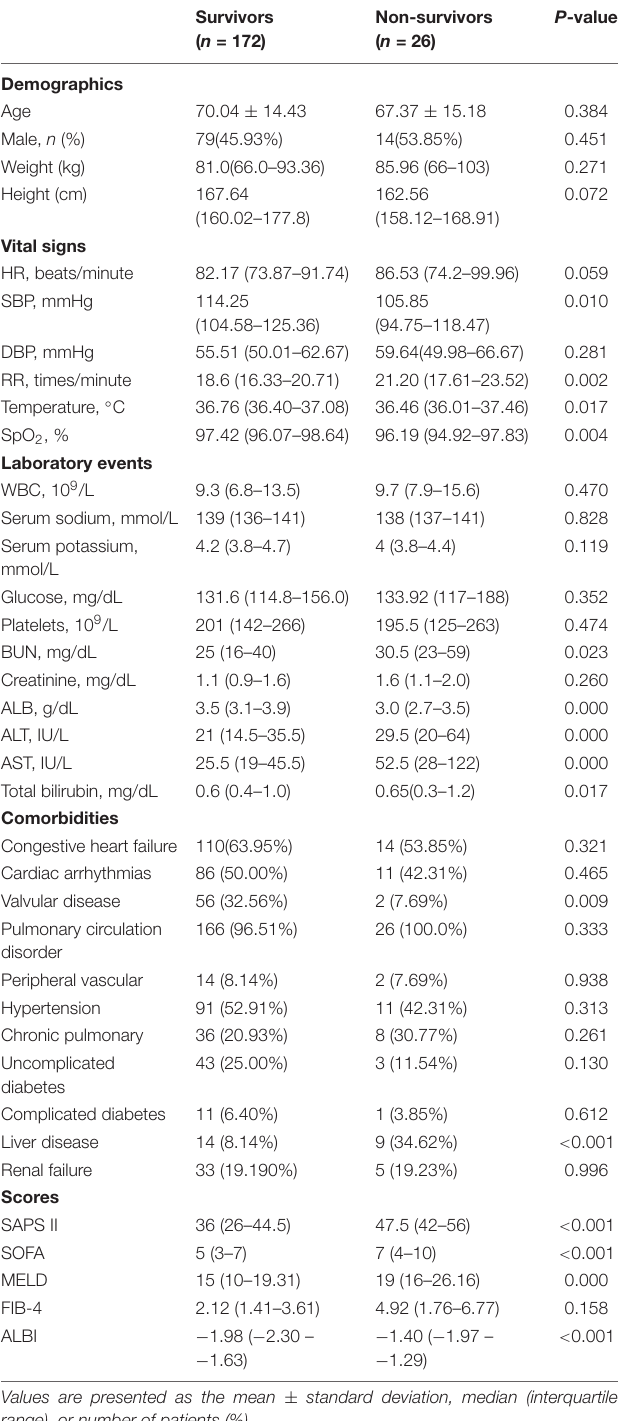
TABLE 1 | Baseline characteristics of the study population with different survival status in